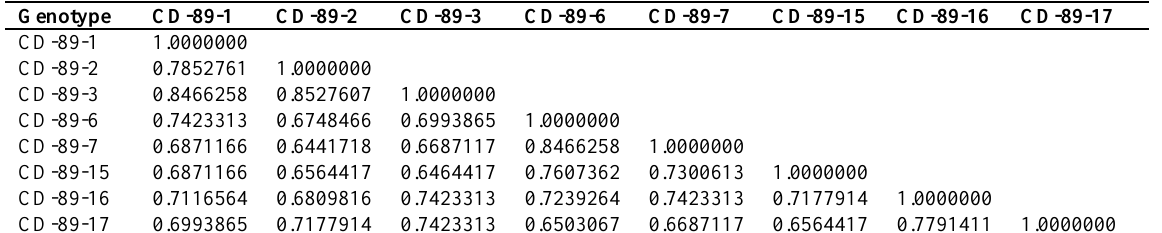
Table 5. The similarity matrix of eight wheat